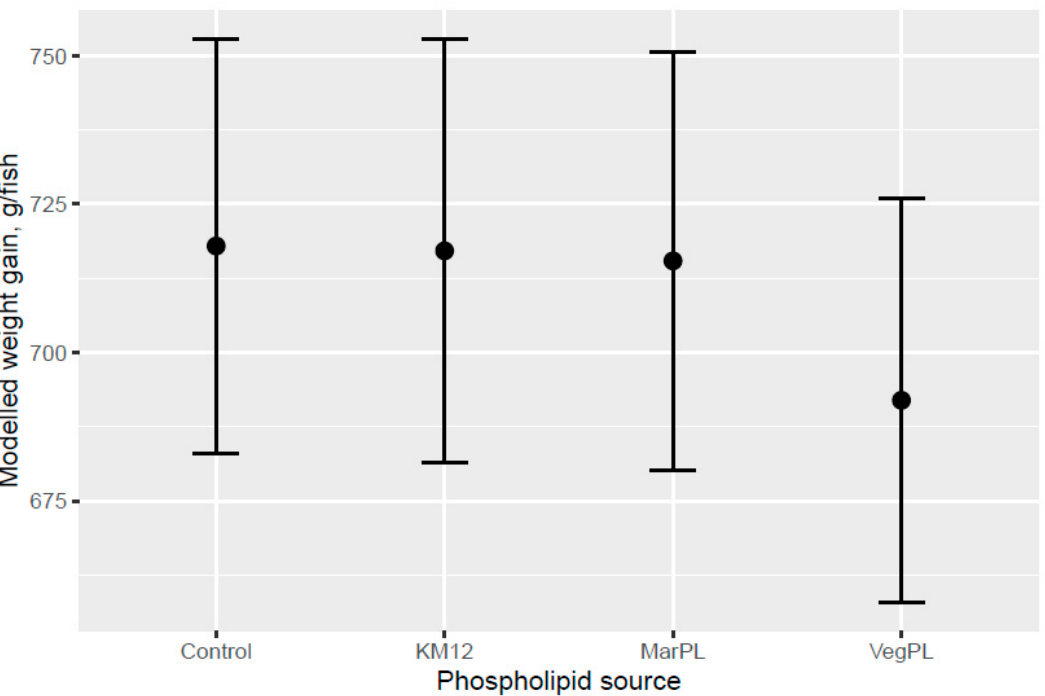
Figure 6. Modelled weight gain after feeding diets with different phospholipid sources for the whole trial, with 53 d in the freshwater pre-transfer phase on test diets followed by feeding the same commercial diet over 98 d in the common seawater tank. The bars are plotted with 95% credible intervals. Dots denote observed tank mean weight